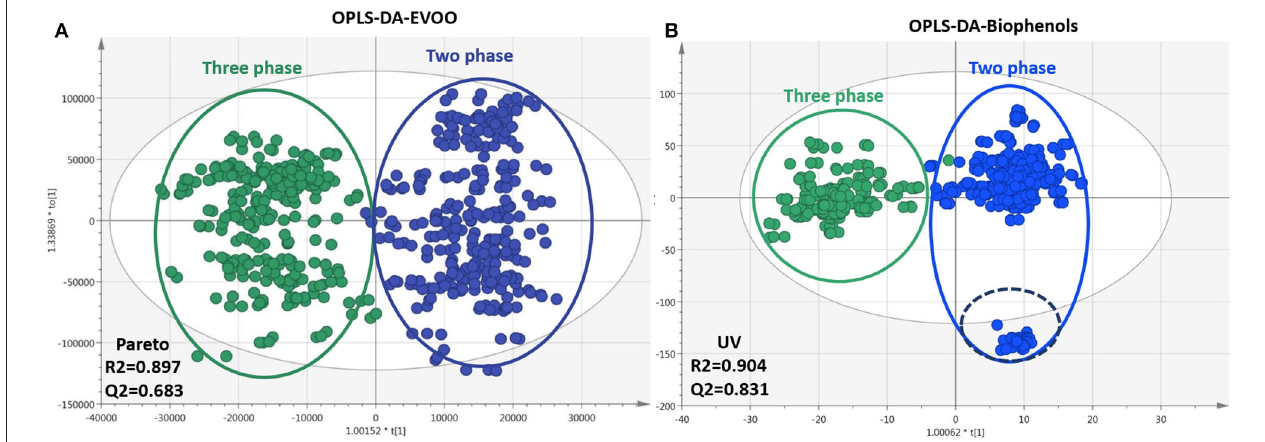
FIGURE 8 | Plots of EVOOs and their corresponding biophenols extracts acquired via FIA-MRMS. Plots include the total number of observations and are colored according to production procedure classID: three phases (green), two phases (blue). (A) OPLS-DA of EVOOs treated with pareto scaling. (B) OPLS-DA of biophenols treated with UV scaling. R2/Q2 model parameters are annotated